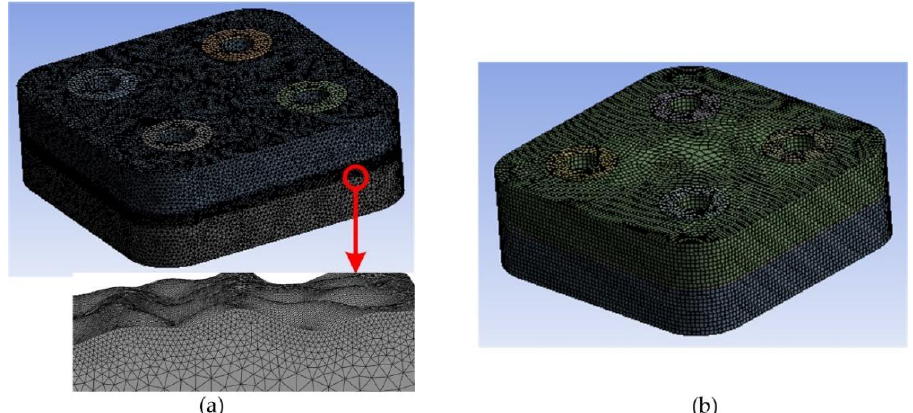
Figure 5. 3D mesh of finite element simulation. ( a ) the meshed model without EM and a view to the amplified area; ( b ) the meshed model with EM.